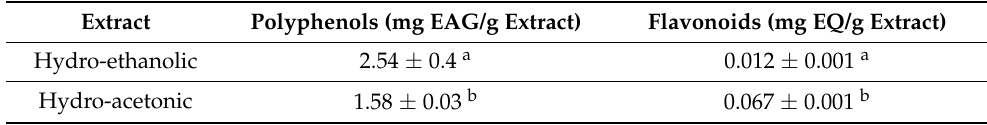
Table 2. Measurement of phytochemical compound concentration. Extract Polyphenols (mg EAG/g Extract) Flavonoids (mg EQ/g Extract) Hydro-ethanolic 2.54 ± 0.4 a 0.012 ± 0.001 a Hydro-acetonic 1.58 ± 0.03 b 0.067 ± 0.001 b Values in each column that have a distinct letter are statistically different ( p <